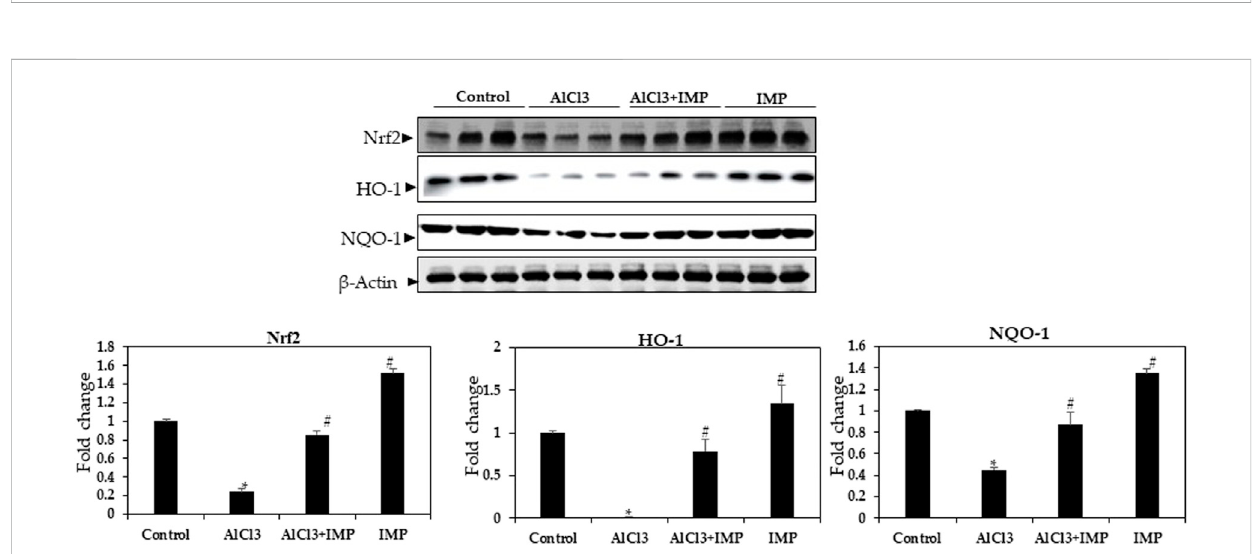
FIGURE 7 Expression of Nrf2 in brain homogenates. Western blot analysis of Nrf2, HO-1, and NQO-1 expression in control and experimental animals. The difference between the treatment and control groups was statistically signi fi cant; * p < 0.05, # p < 0.05 was considered statistically signi fi cant. Values are expressed as mean ± SD, n = 3. * p < 0.05 indicates signi fi cant differences between the AlCl3-alone group and the control group. # p < 0.05 shows signi fi cant differences between AlCl3 alone and IMP with